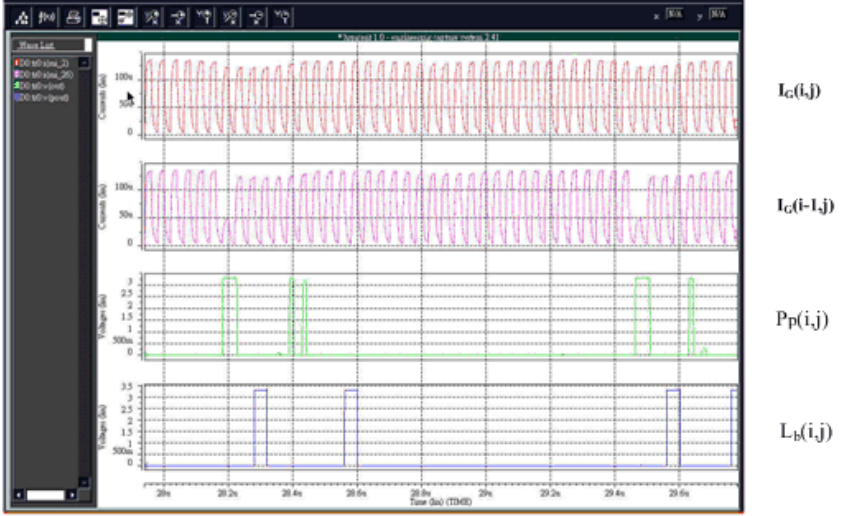
(i,j), I (i-1,j), P (i,j), and L G G p